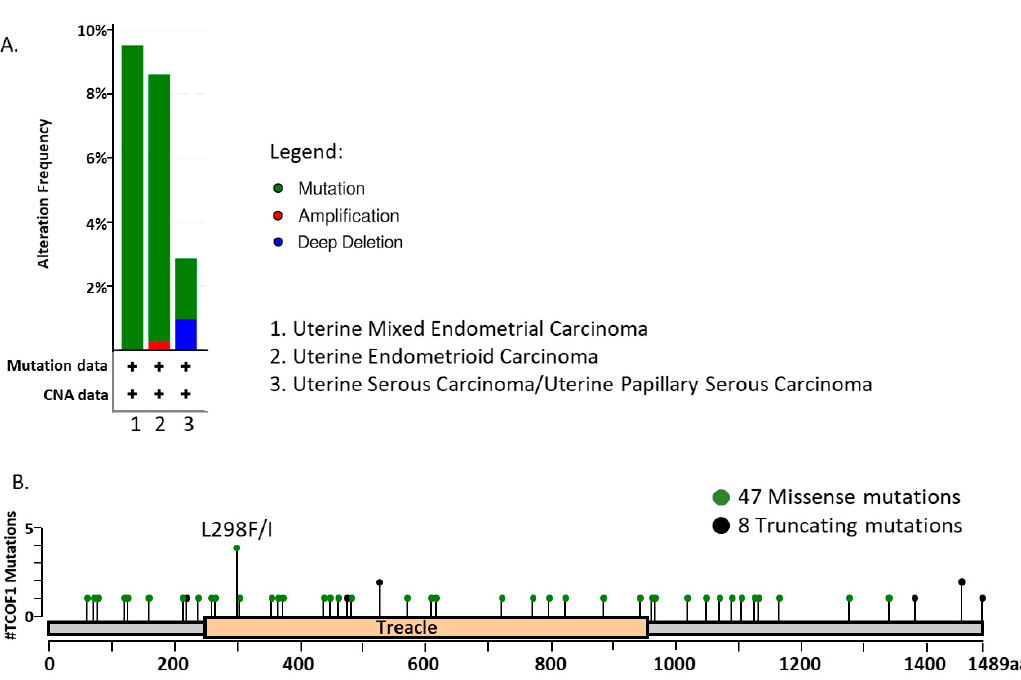
Figure 6. TCOF1 mutations in uterine carcinoma. ( A ) The frequency of TCOF1 alterations in 509 samples of uterine carcinomas, classified as uterine mixed endometrial carcinoma ( n = 21), uterine endometrioid carcinoma ( n = 383), and uterine serous carcinoma/uterine papillary serous carcinoma ( n = 105). ( B ) Graphical representation of mutations identified in uterine carcinomas. In total, 55 TCOF1 mutations were found in 509 samples of uterine carcinomas. The figure shows results of bioinformatic analysis of the publicly available transcriptomic data of The Cancer Genome Atlas, retrieved and analyzed using cBio platform (http://www.cbioportal.org/, accessed on 11 May 2020).